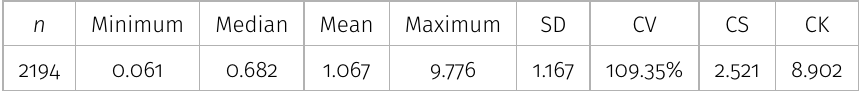
Table III. Summary statistics for the BASF-SE